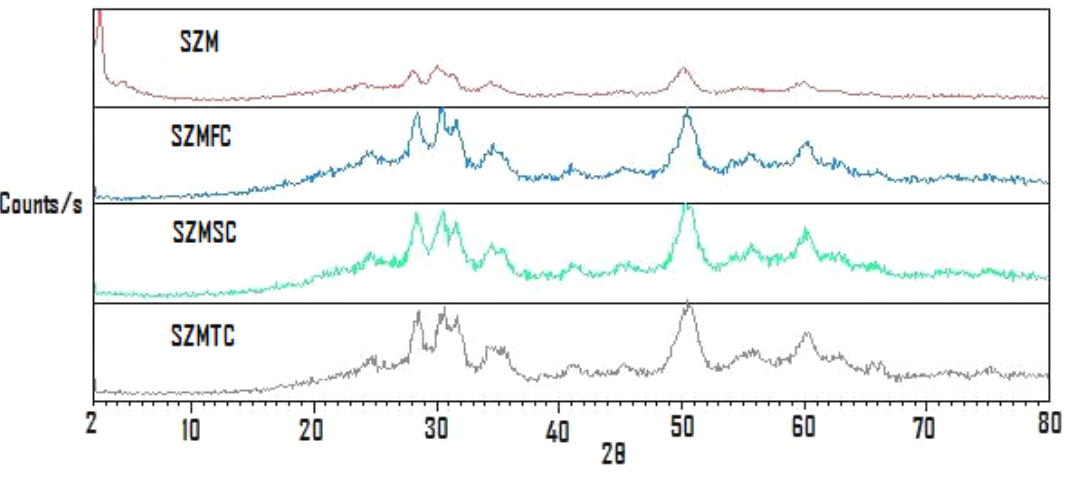
Figure 2. XRD traces of sulphated zirconia over MCM-41 after reactivation